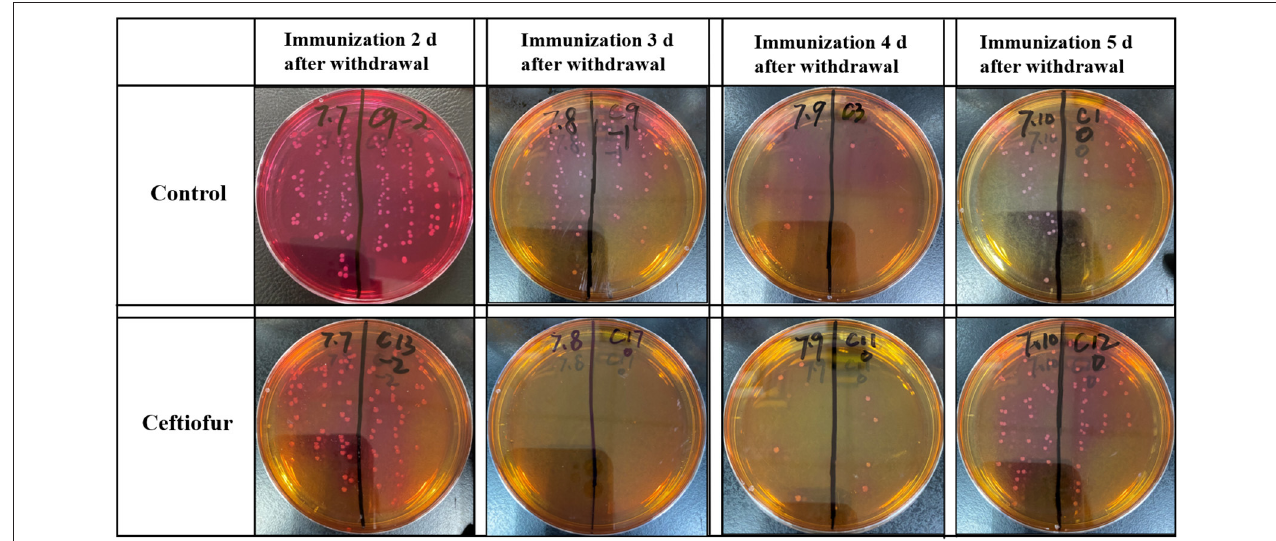
FIGURE 3 | Isolation of Salmonella from cecum after from the ceftiofur groups. No Salmonella vaccine strains were isolated from the cecum of chickens immunized at 3 days after ceftiofur withdrawal. In chicks immunized at other times after withdrawal, the Salmonella vaccine strain could be isolated from the cecum. The Salmonella vaccine strain appears as reddish smooth colonies on Brilliant-Green Phenol-Red Lactose Sucrose